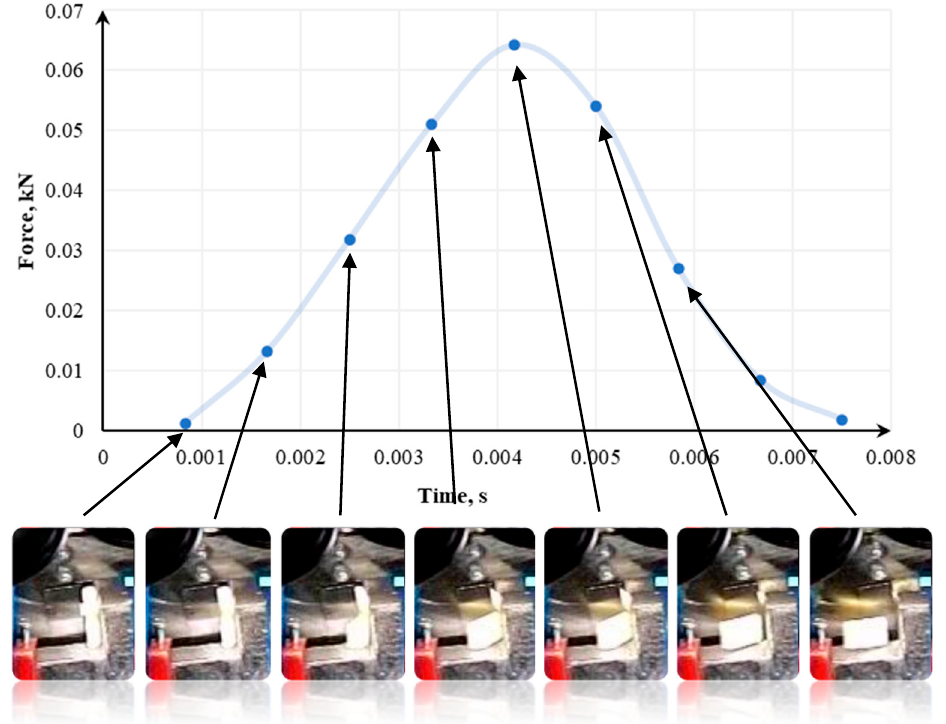
Figure 17. Momentary force values during grinding of a single polypropylene sample in a vertical arrangement using a 90° knife.